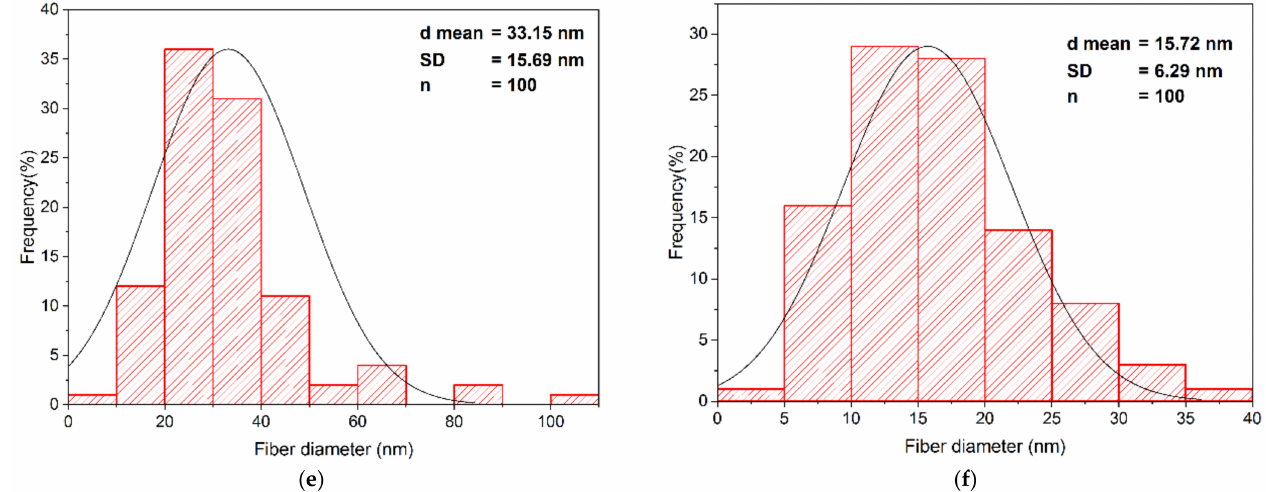
Figure 2. FESEM morphology in the surfaces of the UB-0 ( a ) and the UB-750 ( b ) and in the cross- sections of the UB-0 ( c ) and the UB-750 ( d ), and the average diameter distribution of nanofibers from Figure 2a ( e ) and Figure 2b ( f